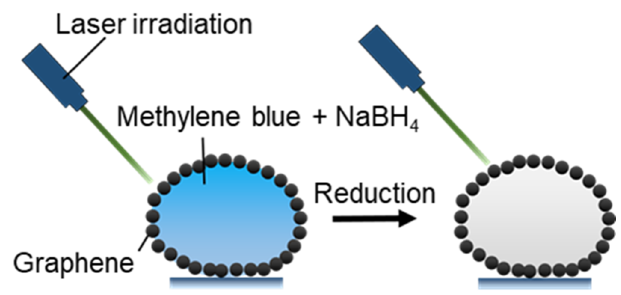
Figure 6. Photothermal heating of a liquid marble for the reduction of methylene blue [73].